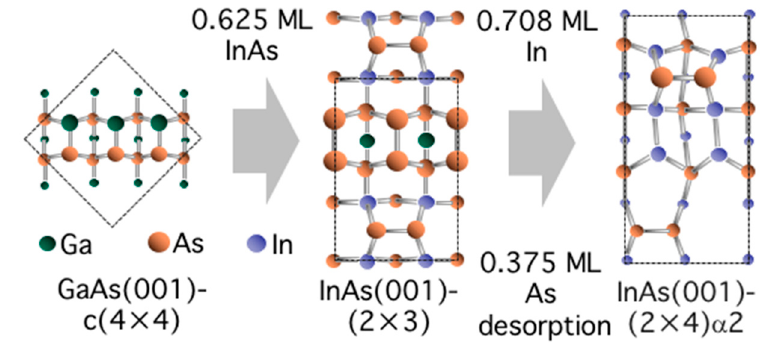
Figure 7. Schematic of structural change during MBE growth from initial GaAs(001)-c(4 × 4) to InAs(001)-(2 × 4) α 2 via InAs(001)-(2 × 3). Green, blue, and orange atoms denote Ga, In, and As, respectively.